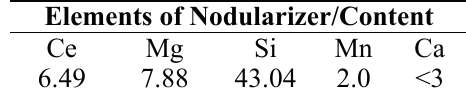
Table 1. Composition of nodularizer